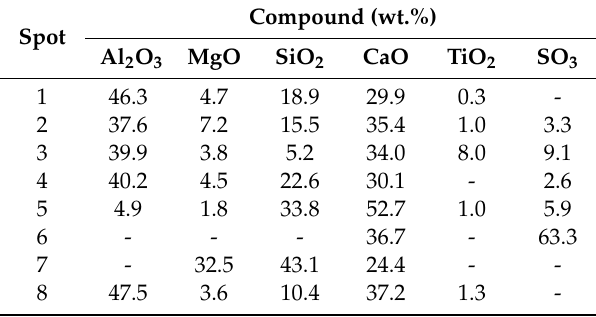
Figure 5. Slag-refractory interface of sample MgO-C at 30 × magnification ( a ), space between grains filled with slag at 1000-times magnification ( b ), interface of sample M-AR-C at 30-times magnification ( c ) and grain filled with slag at 200 × magnification ( d ), and slag-refractory interfaces of sample M-CMA-C at 30-times magnification ( e , f ) including marks of EDS spot analysis. Table 5. Results of EDS spot analysis in